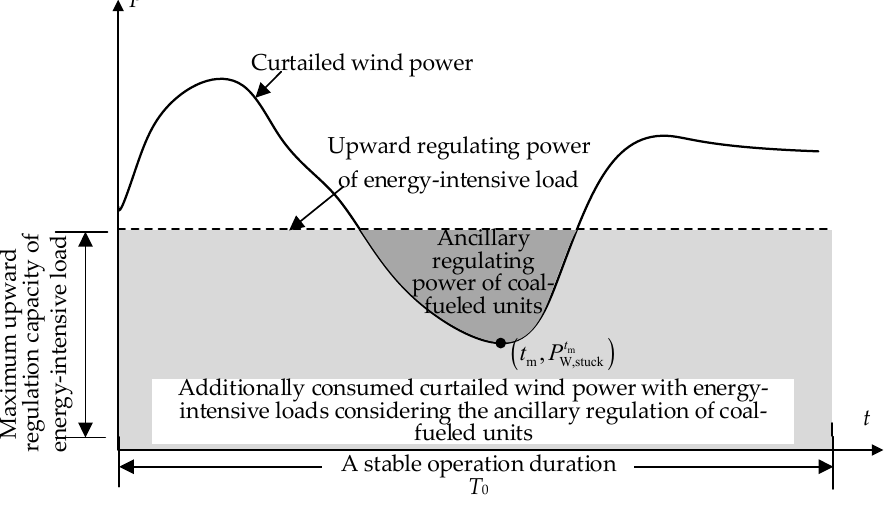
Figure 4. Curtailed wind power consumption with energy-intensive loads considering the ancillary regulation power of coal-fueled units.